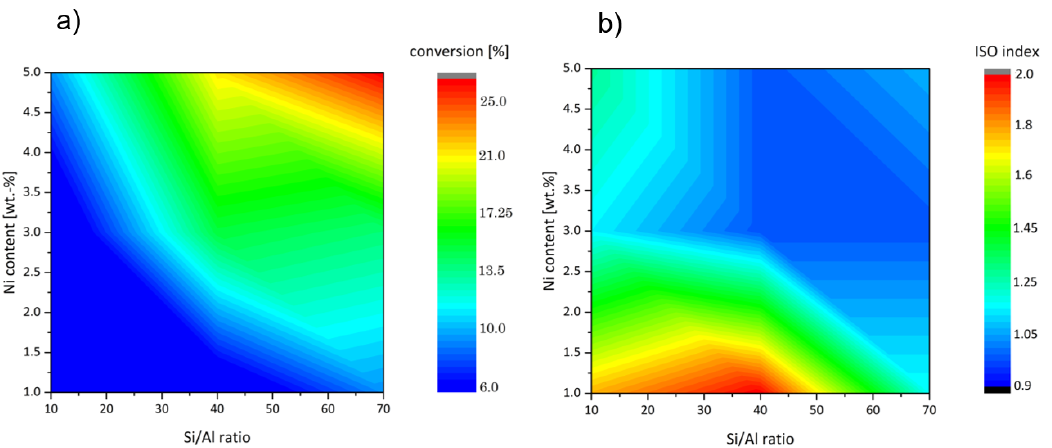
Figure 2. ( a ) Conversion of n-butenes and ( b ) ISO index as a function of the Si/Al ratio and nickel content. The colors encode the numerical value in %. (blue → red): conversion (3 → 26), ISO index (0.9 → 2.0).